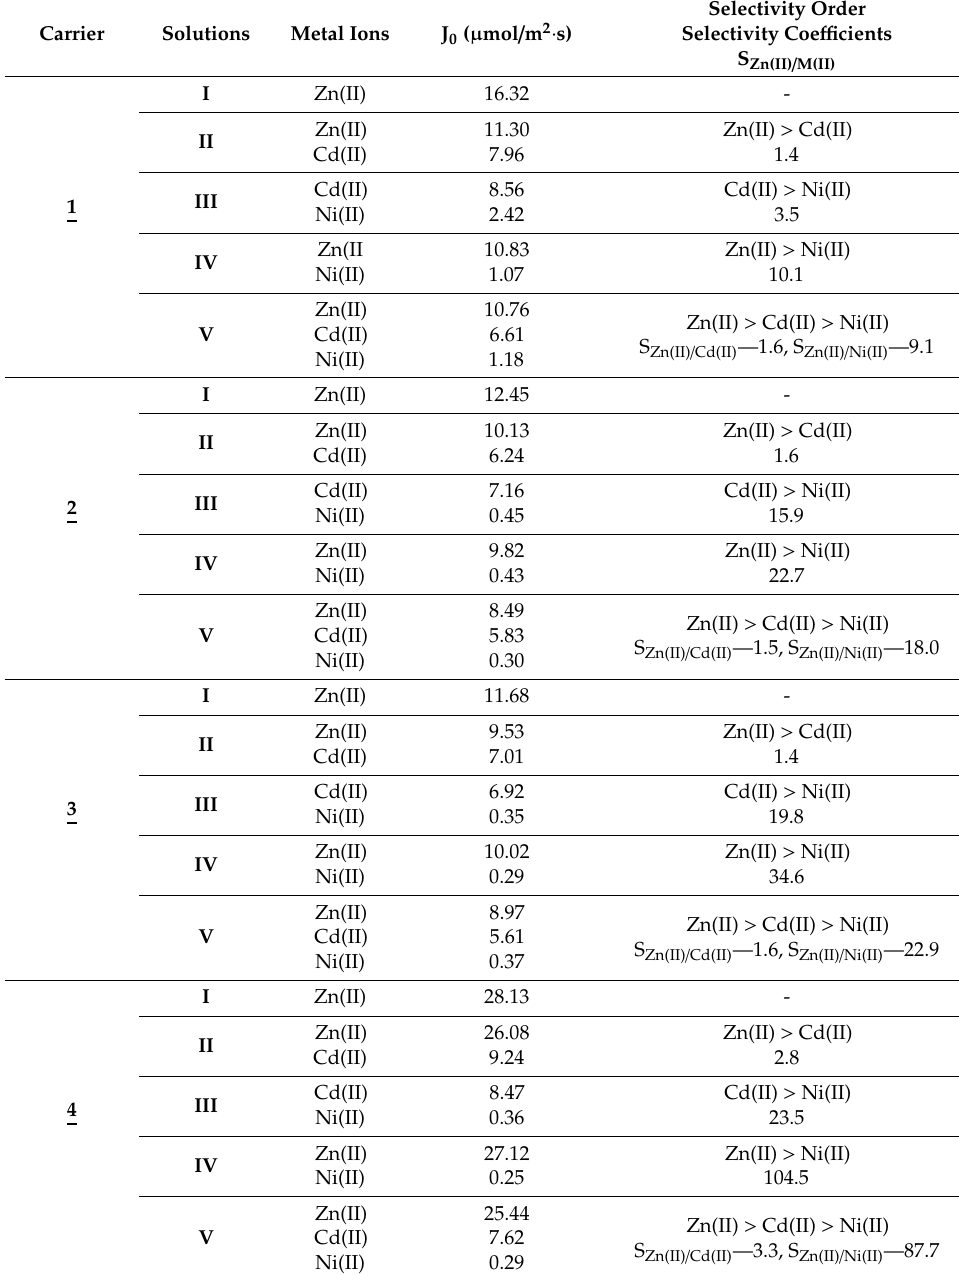
Table 2. Initial fluxes (J 0 ), selectivity order, and selectivity coe ffi cients (S) for the competitive transport of Zn(II), Cd(II), and Ni(II) ions across PIMs doped with alkylimidazoles 1 –